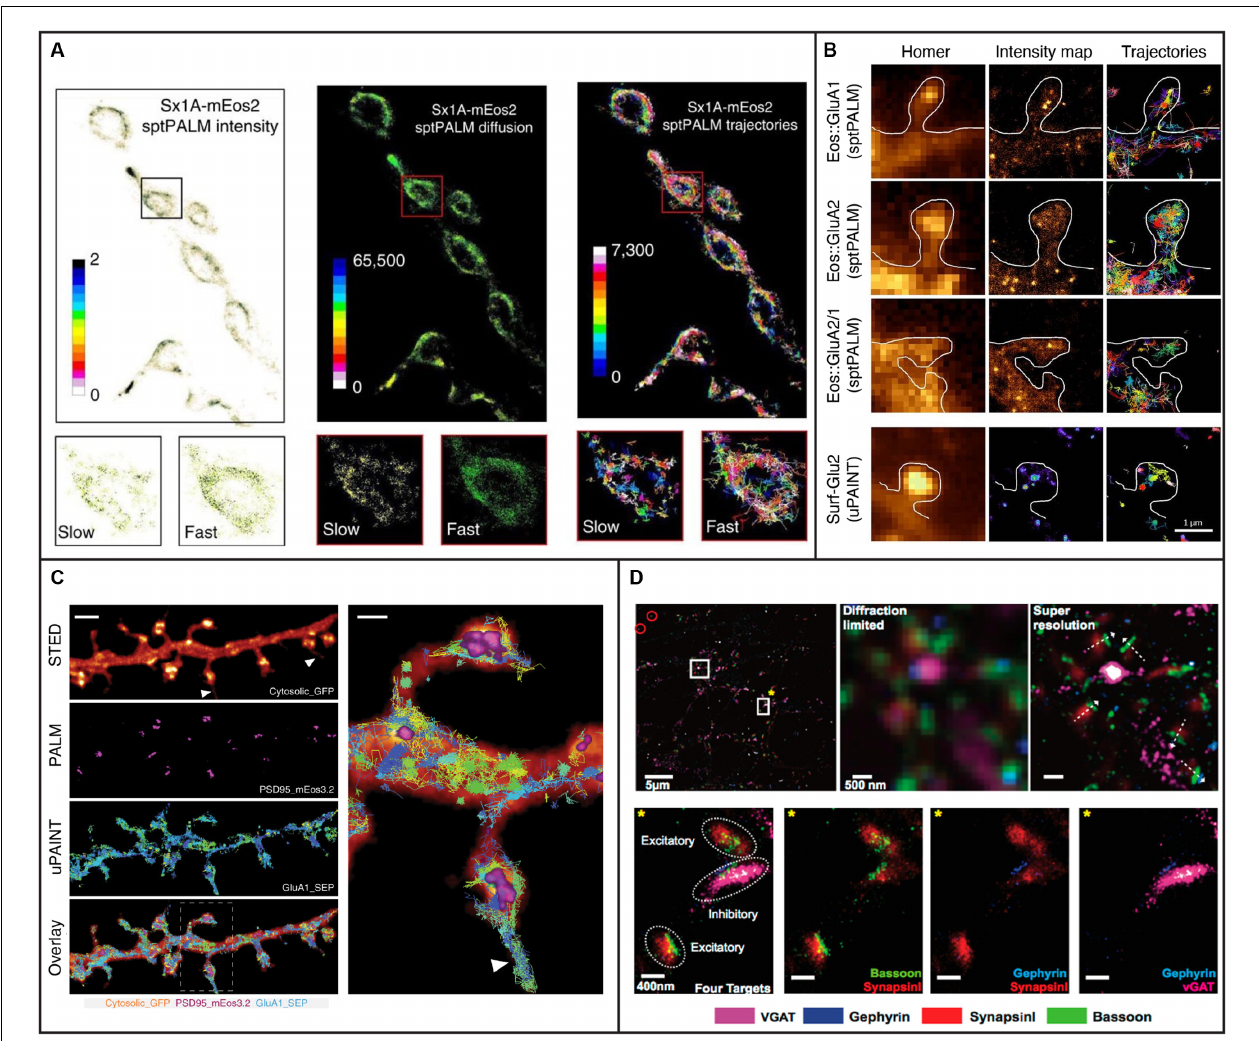
FIGURE 3 | Examples of 2D single-molecule tracking and 2D super-resolution imaging in neurons and synapses. (A) sptPALM was used to image the distribution and mobility of attachment receptor protein syntaxin1A fused with photoconvertible fluorescent protein mEos2 in the motor nerve terminal of Drosophila larvae. Insets demonstrate average intensity, diffusion coefficient, and trajectory map showing slow and fast populations of syntaxin1A on a synaptic bouton. Figure reprinted from Bademosi et al. (2016). Reprinted with permission from Springer, under Creative Commons Attribution 4.0 International License. (B) The organization of AMPA receptors into nanodomains inside the spines of live hippocampal neurons demonstrated with single-molecule tracking techniques sptPALM and uPAINT. The first column shows diffraction-limited images of Homer1c and the following two columns show intensity maps and trajectories from measurements using sptPALM (top three rows) or uPAINT (bottom row). The scale bar is 1 µ m. Adapted from Nair et al. (2013) (https://www.jneurosci.org/content/33/32/13204). (C) Combining deterministic approaches STED and SUSHI with stochastic techniques PALM and uPAINT enabled correlative super-resolution imaging of neuron morphology and analysis of the distribution and dynamics of synaptic proteins in live hippocampal neurons. The right panel is a close up of the area marked with a rectangle in the overlay. The scale bar is 2 µ m in the left panel and 500 nm in the close up. Reprinted by permission from Springer Nature: Springer Nature, Nature Methods, (Inavalli et al., 2019), copyright 2019. (D) The four synaptic proteins vGAT, Gephyrin, SynapsinI, and Bassoon imaged sequentially with Exchange-PAINT. The top left panel shows a merged image of the synaptic proteins, where gold nanoparticles were used as fiducials for registration (circled in red). The scale bar is 5 µ m. The top middle and top left panels show diffraction-limited and super-resolved images, respectively, of the region in the top left panel marked with a white square without a star. The super-resolved image allows distinction of the orientation of individual synapses as shown with white arrows. The scale bar is 500 nm. The bottom panels show the region marked with a white square and yellow star in the top left panel. The four targeted synaptic proteins are first shown together and then pair-wise. The scale bars are 400 nm. Reprinted with permission from Wang et al. (2017). Copyright (2017) American Chemical Society.